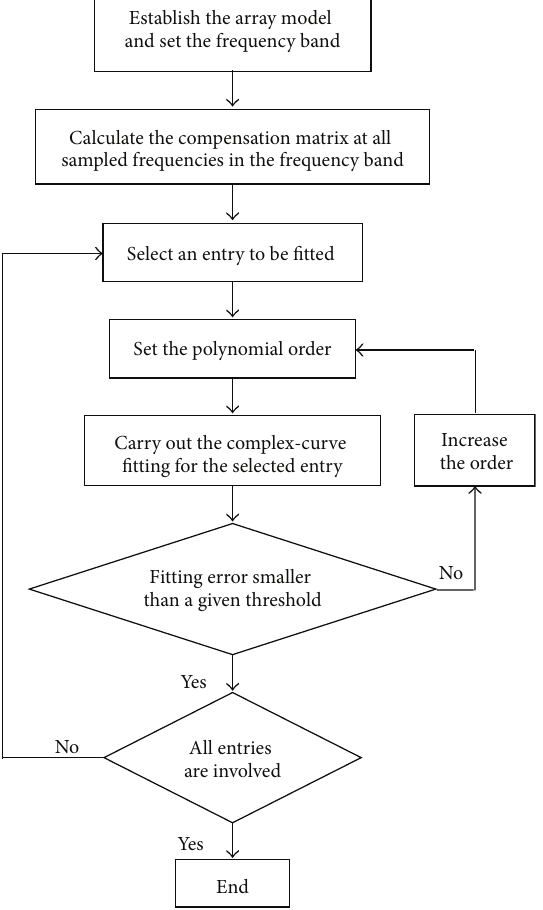
Figure 1: Flowchart for the calculation of wideband compensation